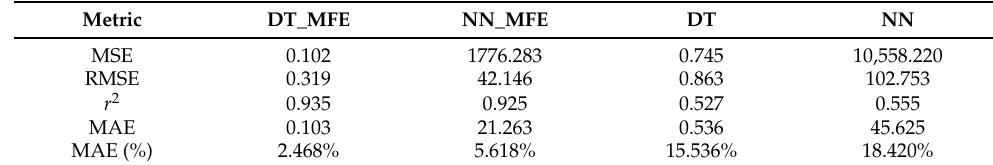
Table 4. Comparison of the main performance metrics for the 4 meta-models, obtained through 5-fold cross-validation on training data (metrics computed for combined holdout